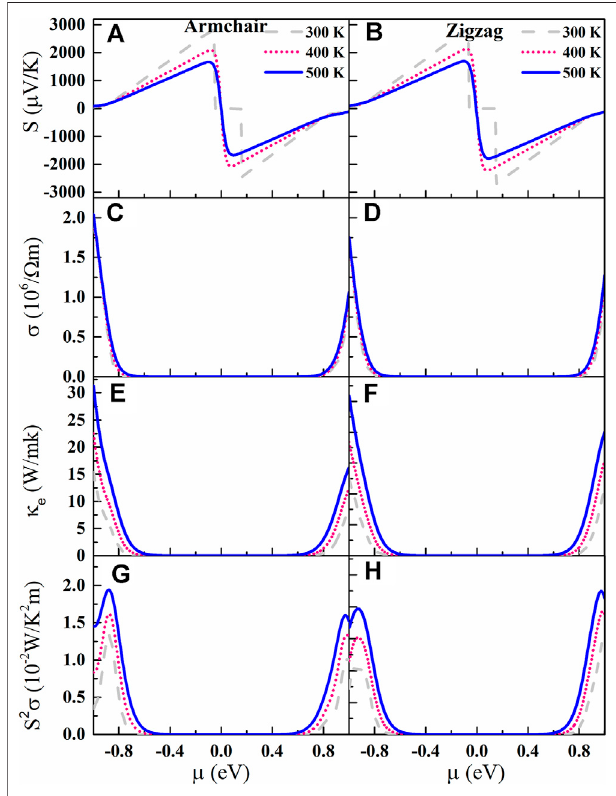
FIGURE 3 | (A) – (H) Seebeck coef fi cients, electrical conductivity, electrical thermal conductivity, and power factor vs. chemical potential µ at different temperatures (300, 400, and 500 K).